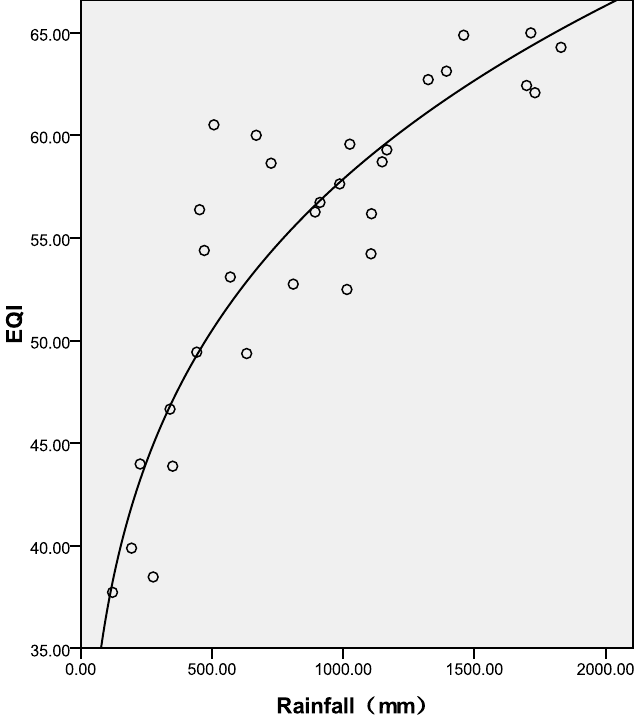
Figure 6. Best-fit curve for EQI and rainfall at the provincial level in 2005.